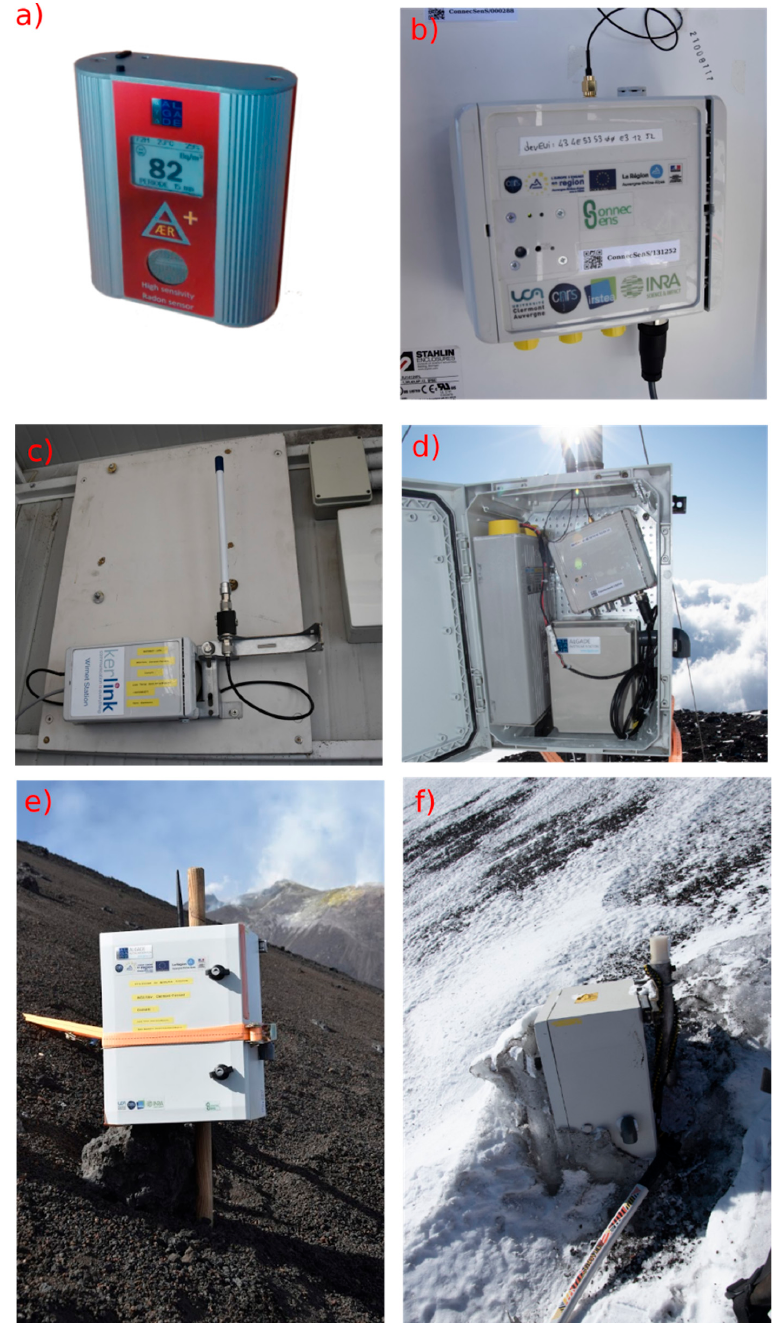
Figure 2. Different views of the equipment installed on Mt. Etna: ( a ) the ÆR+ sensor; ( b ) the communicating node; ( c ) the gateway in Montagnola Shelter; ( d ) the radon station on Mt. Frumento Supino comprising the ÆR+ box, the battery, and the communicating node; ( e ) the radon station on Mt. Barbagallo in September 2019; and ( f ) the same station in December 2019.